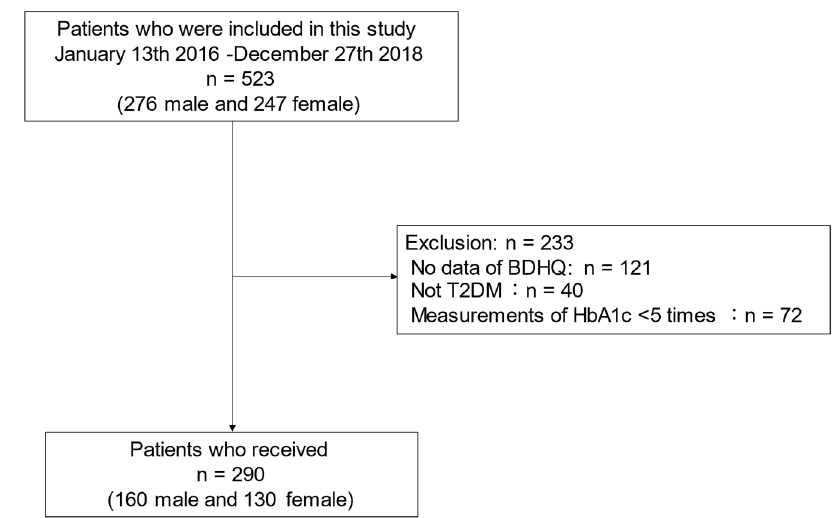
Figure 1. Inclusion and exclusion flow.